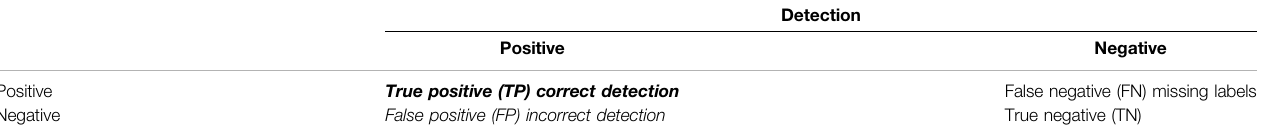
TABLE 2 | Recall scores [TP/(TP+FN)] in the confusion